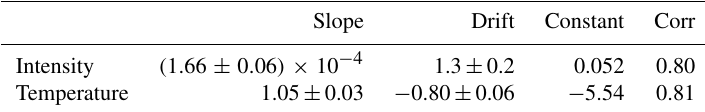
Figure 6. SATI (black) nighttime OH predicted layer altitude (top), total band intensity (middle) and rotational temperature (bottom) for four nights in October 2009 (a) and from 2 August 2013 to 14 August 2013 (b) . Fit to a combination of oscillations is shown in orange (see text). Purple asterisks are SABER colocated measurements (intensities and temperatures have been transferred to SATI scale). Table 3. Results for the linear transfer function from SATI to SABER measurements. Slope is expressed in (ergcm − 2 s − 1 )A.U. − 1 for intensity and is unitless for temperature. Drifts are expressed in % per year and K per year, respectively. Constant units are in ergcm − 2 s − 1 and K,